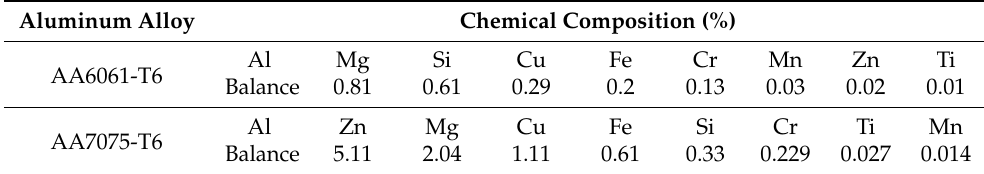
Table 1. Chemical composition of AA6061-T6 and AA7075-T6 Aluminum alloys. Aluminum Alloy